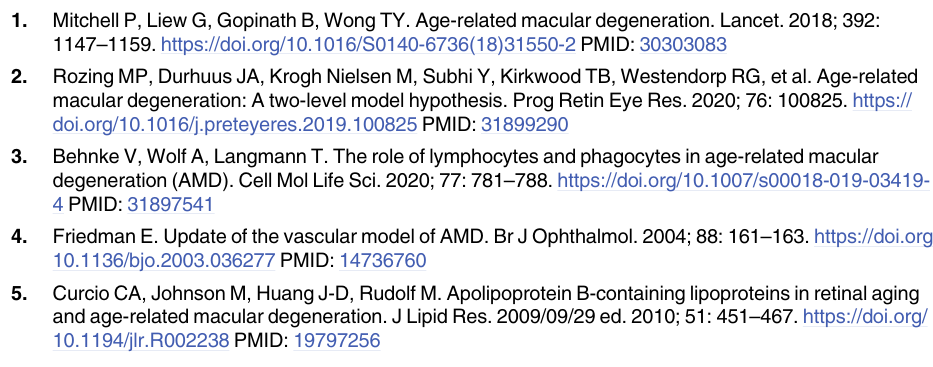
S1 Fig. Exclusion criteria. Graphic representation of exclusion criteria applied to build final analytic sample. S2 Fig. Forest plot of unadjusted cox proportional hazards models. Forest plot demonstrat- ing unadjusted cox proportional hazards models of patients exposed to lipid-lowering medica- tions and their progression to exudative AMD and/or need for treatment with anti-VEGF medication. S3 Fig. Forest plot of adjusted cox proportional hazards models using propensity score matching. Forest plot demonstrating adjusted cox proportional hazards models using propen- sity score matching of patients exposed to lipid-lowering medications and their progression to exudative AMD and/or need for treatment with anti-VEGF